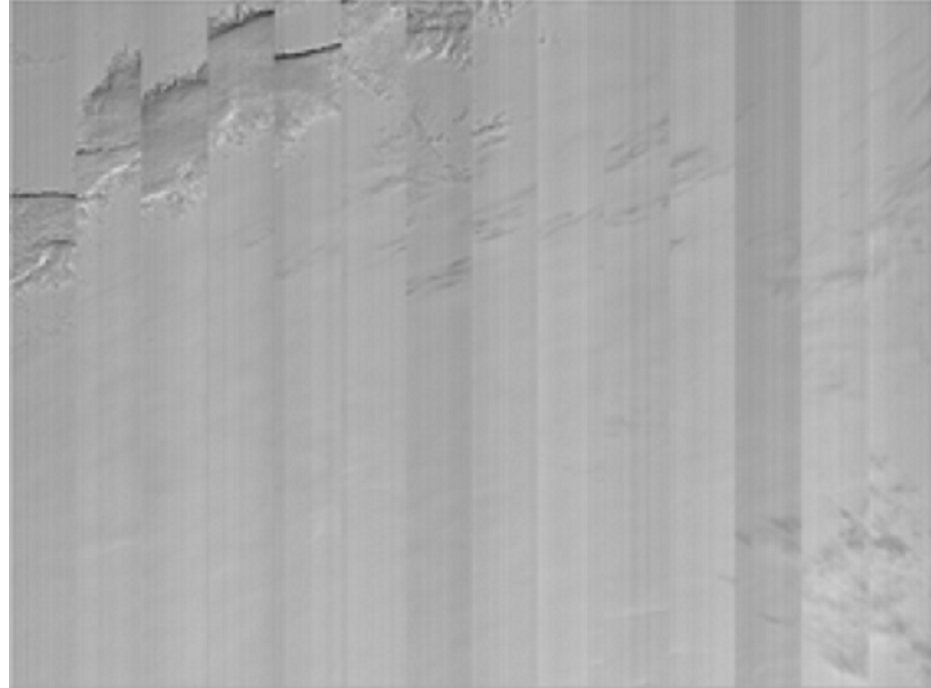
Figure 1. The thick vertical discolorations are FPM-level streaking and contained within them are thin vertical stripes which are detector-level streaking from a Green band test image of